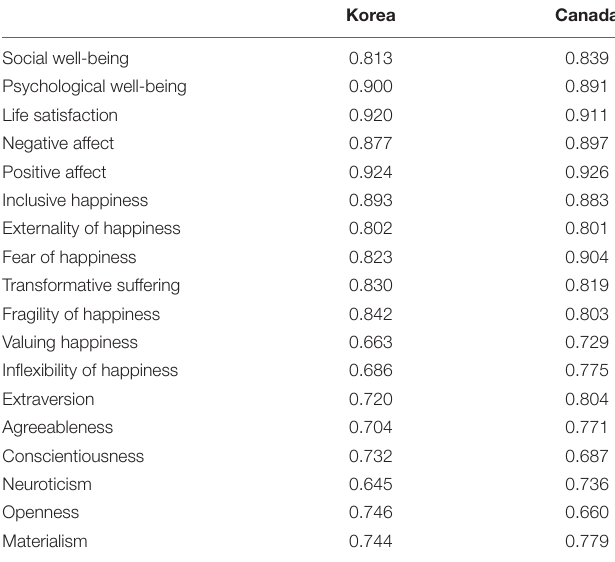
TABLE 2 | Cronbach’s